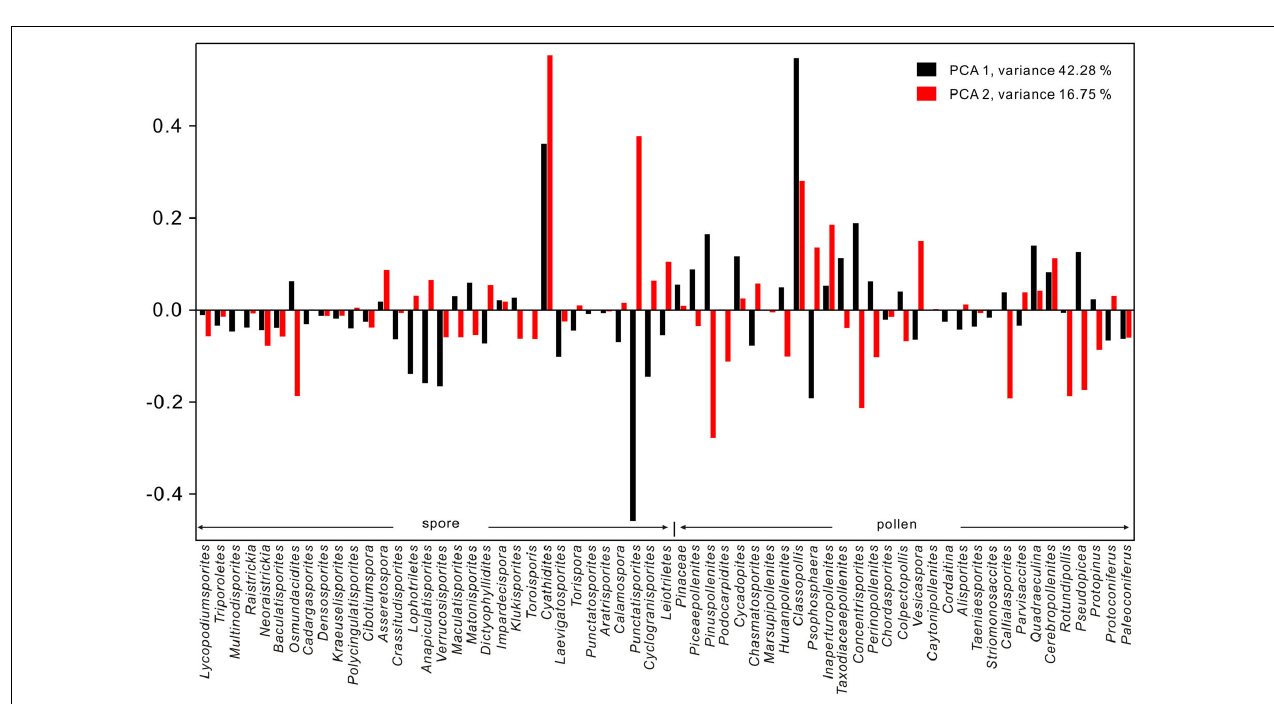
trend through the Jurassic mudstones, siltstones, and sandstone to the top of our succession (samples 24–1; ¯x = 0.44 wt%) ( Figure 2 ). From samples through the complete succession, peak temperature of rock pyrolysis ( T max ) values vary from 442 to 446 ◦ C (¯x = 444.1 ◦ C) ( Supplementary Table 3 ) and indicate